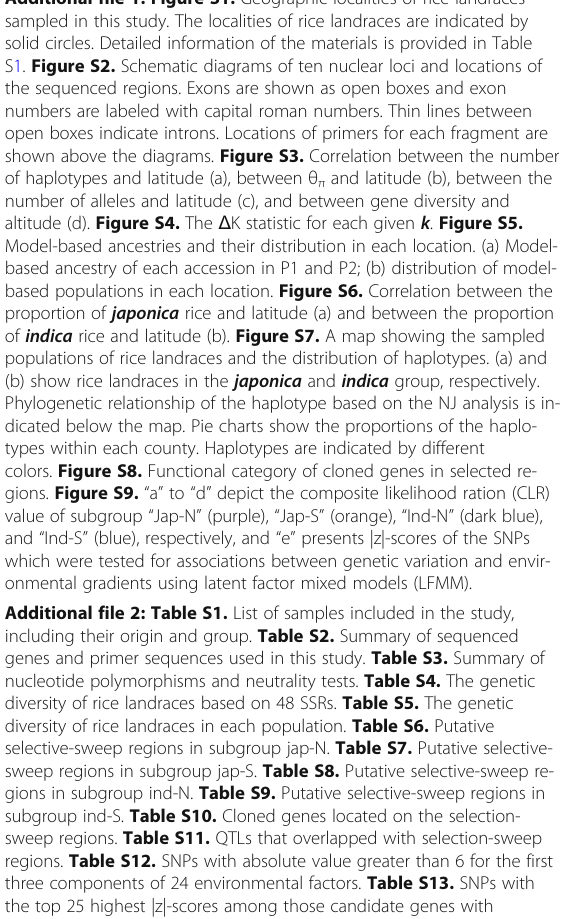
Additional file 2: Table S1. List of samples included in the study, including their origin and group. Table S2. Summary of sequenced genes and primer sequences used in this study. Table S3. Summary of nucleotide polymorphisms and neutrality tests. Table S4. The genetic diversity of rice landraces based on 48 SSRs. Table S5. The genetic diversity of rice landraces in each population. Table S6. Putative selective-sweep regions in subgroup jap-N. Table S7. Putative selective- sweep regions in subgroup jap-S. Table S8. Putative selective-sweep re- gions in subgroup ind-N. Table S9. Putative selective-sweep regions in subgroup ind-S. Table S10. Cloned genes located on the selection- sweep regions. Table S11. QTLs that overlapped with selection-sweep regions. Table S12. SNPs with absolute value greater than 6 for the first three components of 24 environmental factors. Table S13. SNPs with the top 25 highest |z|-scores among those candidate genes with known functions. Table S14. Summary of SSR markers and primer se- quences. Table S15. The detailed information of 24 environmental fac- tors in each population. Table S16. Summary of agronomic traits for rice landraces in each population. The value before the slash shows the data collection from Yunnan, and the value after the slash shows the data col- lection from Hainan.